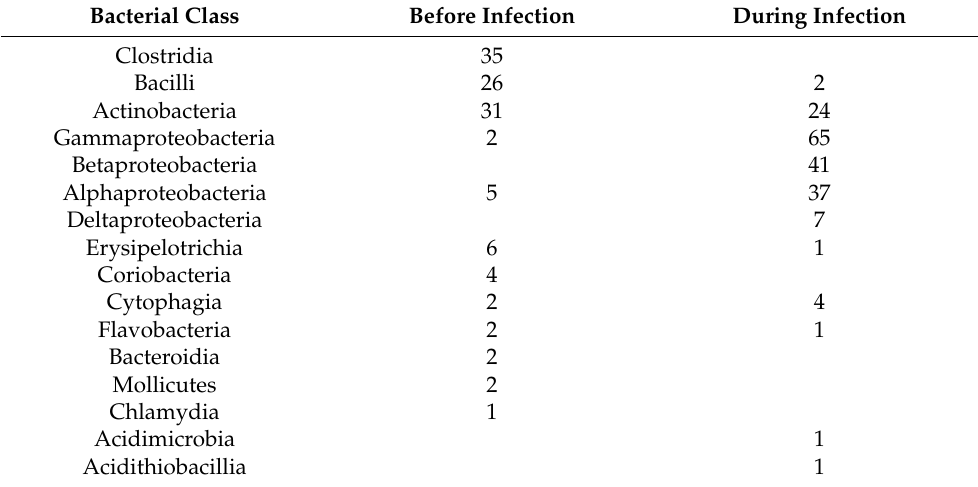
Table 2. The number of unique genera that were differentially abundant 1 before AGE versus during norovirus-associated AGE, by bacterial